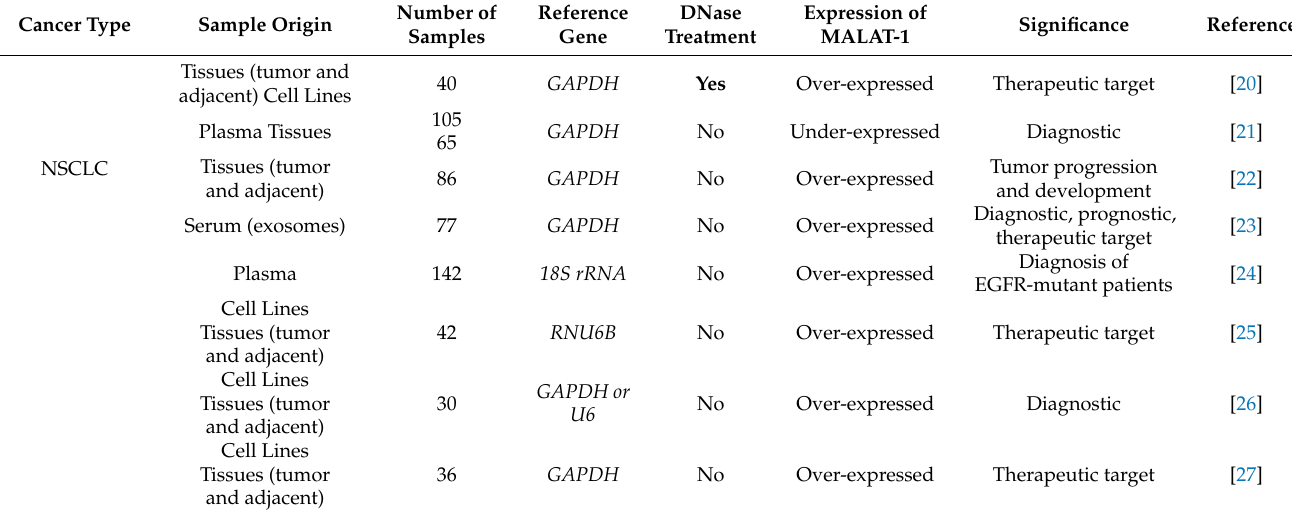
Table 2. MALAT1 expression in